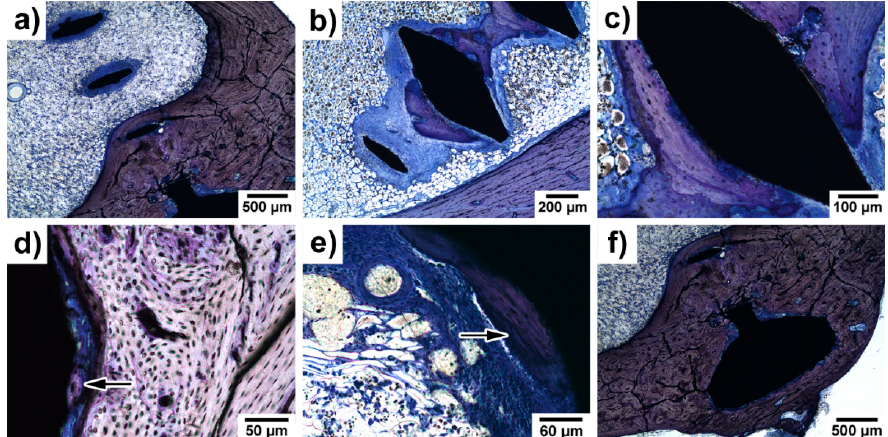
Figure 9. ( a ) Peri-implant fibrosis; ( b , c ) bone formation with tight apposition of the newly created bone to the surface of the experimental screw; ( d ) initial bone formation—detailed view; ( e ) fibroproductive inflammation and initial bone formation; and ( f ) thickened compact bone with the experimental screw embedded. Peri-implant bone formation around the experimental screw is marked by arrows in ( d , e ). At 120 days of implantation. Toluidine blue staining. A summary of the morphological findings on the tibia of the rabbits is shown in Ta- ble. 2. The material was well-tolerated. No gas bubbles were observed. Regular structure of the bone surrounding the implanted material in the majority of rabbits was seen, with only focal irregularities observed in 3 out of the 11 slides examined. Bone cavities were not found. Periosteal remodelling and apposition were present with mild or medium in- tensity. Medium-to-high intensity of endosteal remodelling was also a constant finding in samples with implant/endosteal contact. Peri-implant fibrosis was presented with high intensity (score 3) in all slides with implant/bone interface.